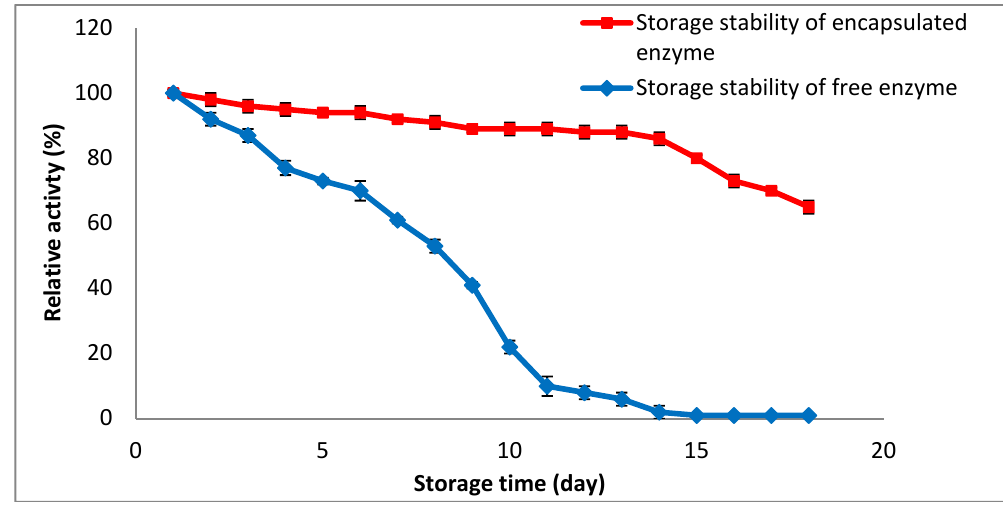
Figure 4. Effect of storage stability on enzyme residual activity.